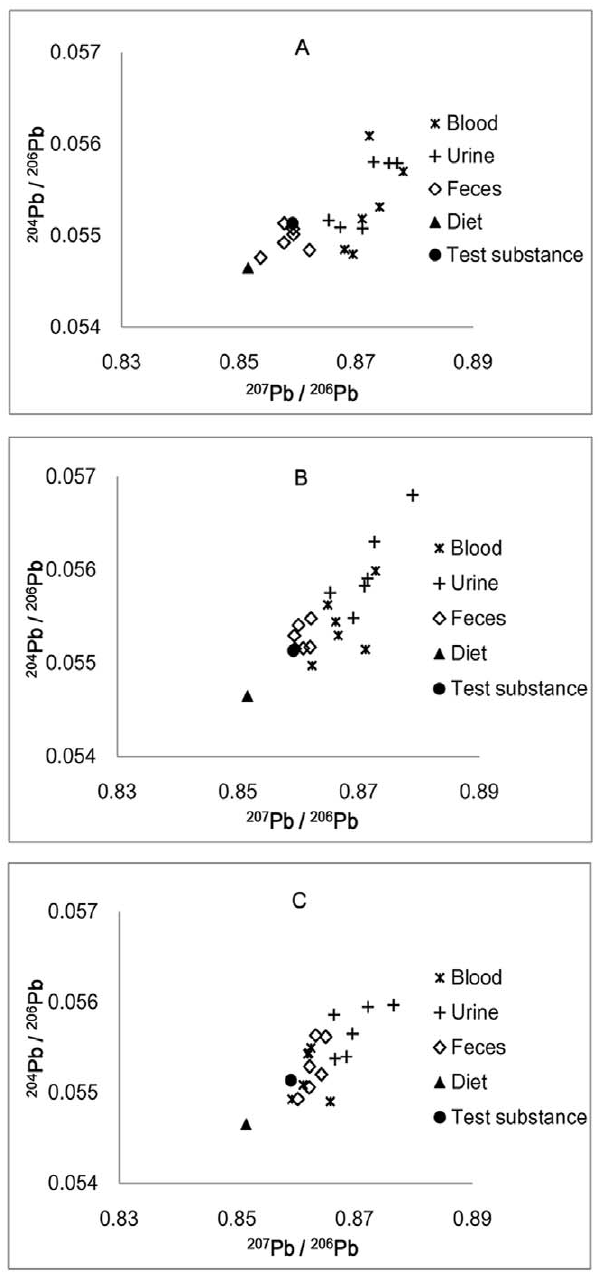
Figure 1. Scatter plot of 204 Pb/ 206 Pb ratio versus 207 Pb/ 206 Pb ratio in different samples. Figure 1A. low-dose group. Figure 1B. medium-dose group. Figure 1C. high-dose group. doi:10.1371/journal.pone.0052462.g001 Table 5–6. In many cases, the X TS and X D in the blood and feces samples were more than 100% or less than zero.